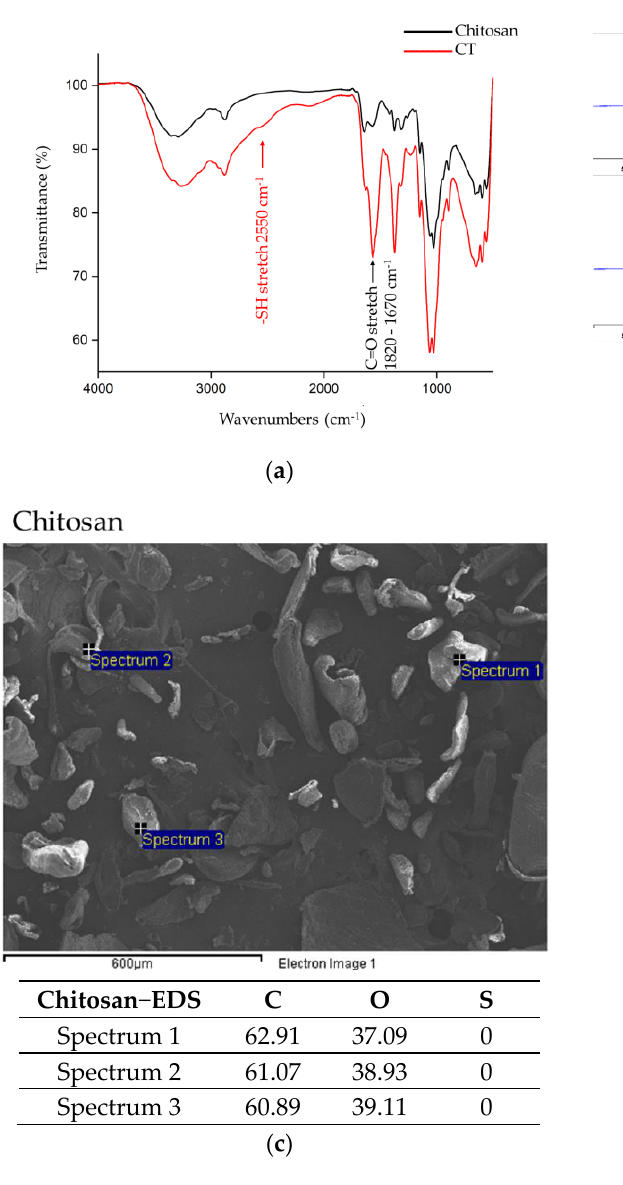
Figure 1. Material molecular structure analysis of CT. ( a ) The FTIR result of chitosan and CT. ( b ) 1 Hydrogen NMR spectra confirmed the structure of chitosan and CT. EDS results showed that there were sulfur signals on the surface of CT ( d ) but not on chitosan ( c ).